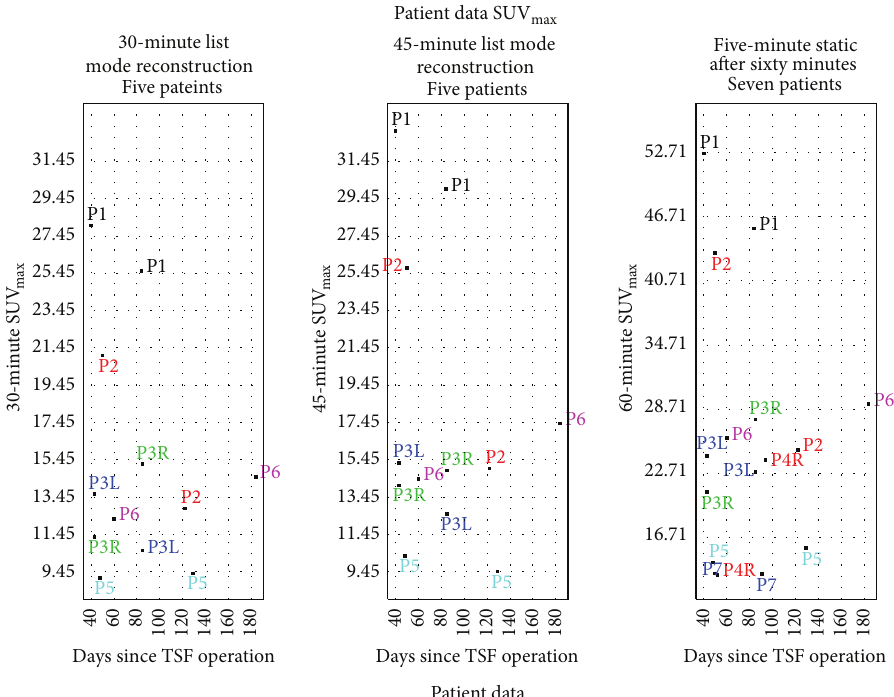
Figure 4: The SUV max for the leg which has the TSF applied plotted as a function of days after the first application of the TSF. Graphs are drawn for five study patients for the 30- and 45-minute reconstructions from list mode using the same scale. A graph is drawn for the seven study patients for the 5-minute static scan taken after 60 minutes on an expanded